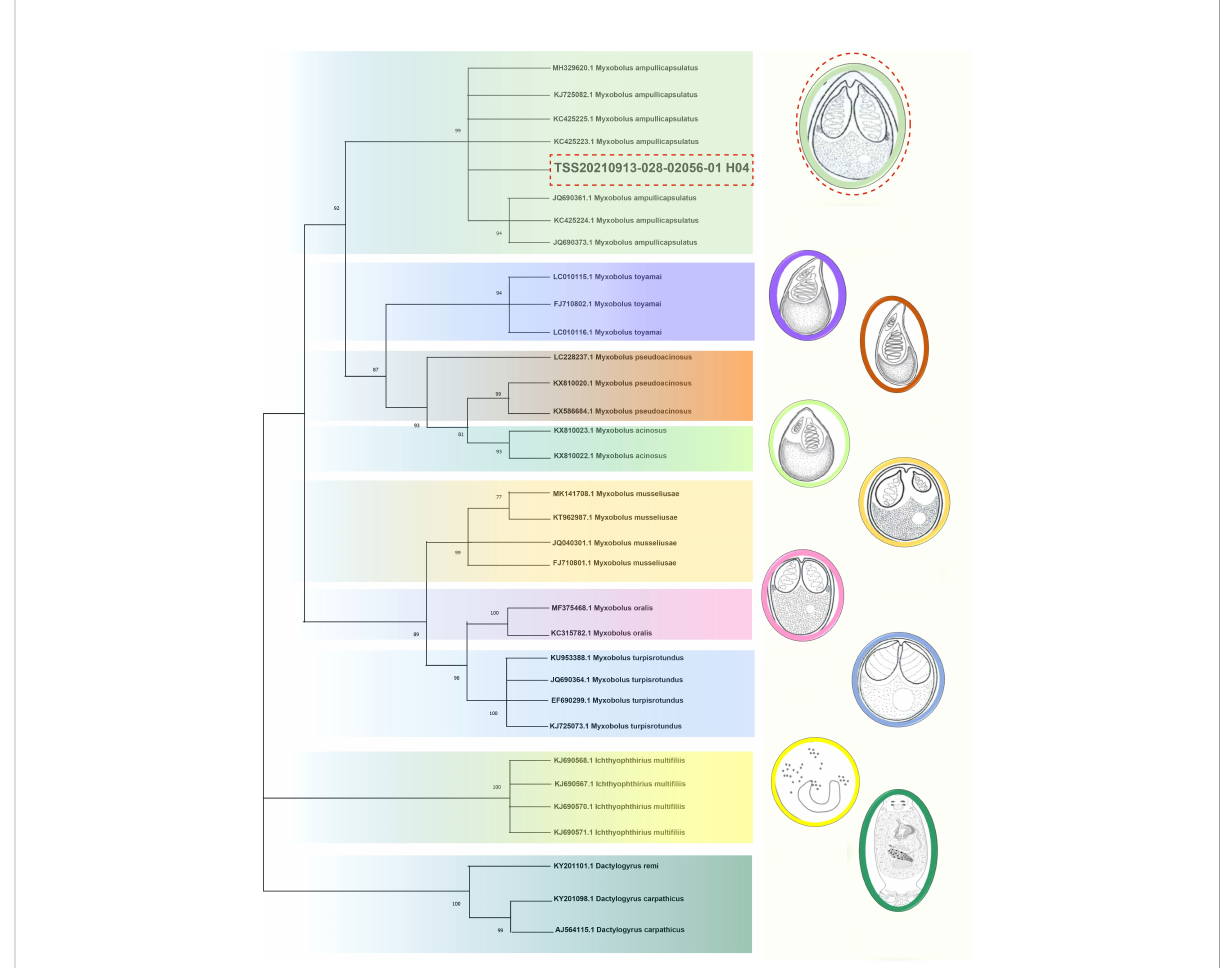
FIGURE 2 Phylogenetic trees based on 18S rDNA sequences using the NJ method with 1000 bootstraps. On the right are different types of Myxobolus and two foreign species (the Ichthyophthirius multi fi liis and the Dactylogyrus ). The same color represents the same species. The red dotted line represents the sequence and Myxobolus ampullicapsulatus pattern diagram of this study. The parasite pattern diagrams were refer from LiuYang (16), Eva R ̌ ehulkova ́ (17) and Luqi Tan